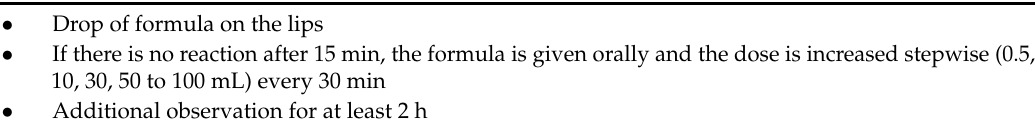
Table 2. Example of standardized protocol for open challenge